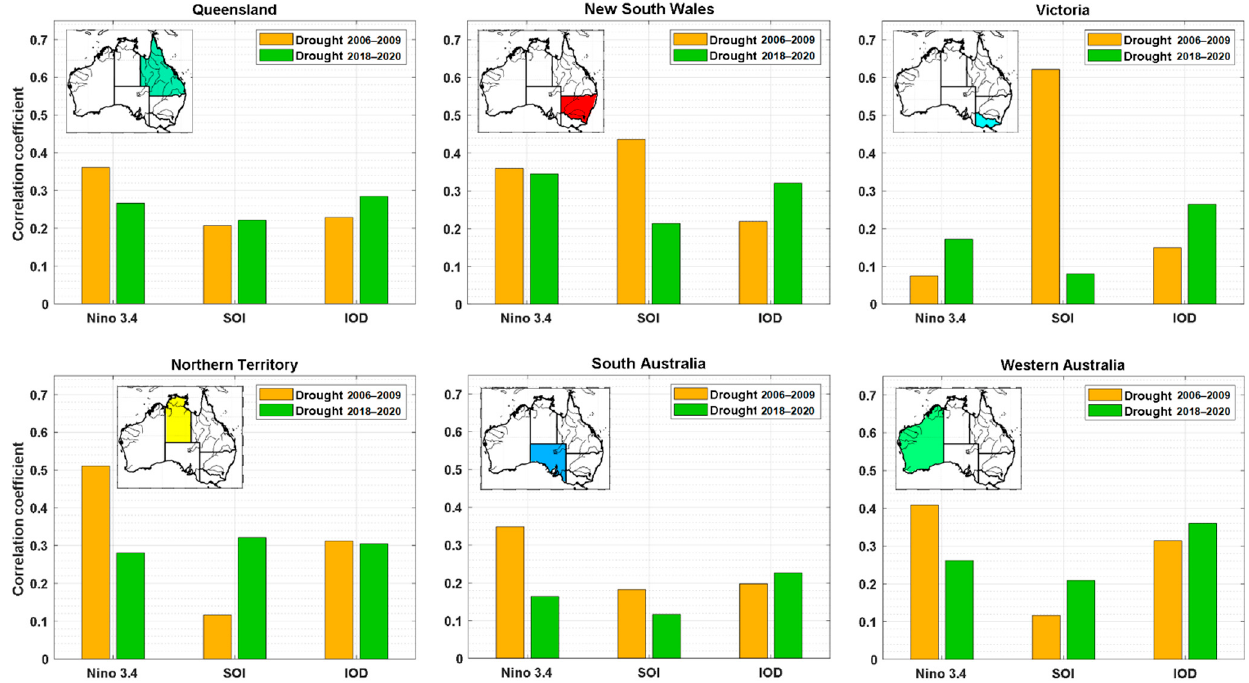
Figure 10. The influences of the three drought driving factors on the 6 regions for Drought 2006–2009 and Drought 2018–2020.